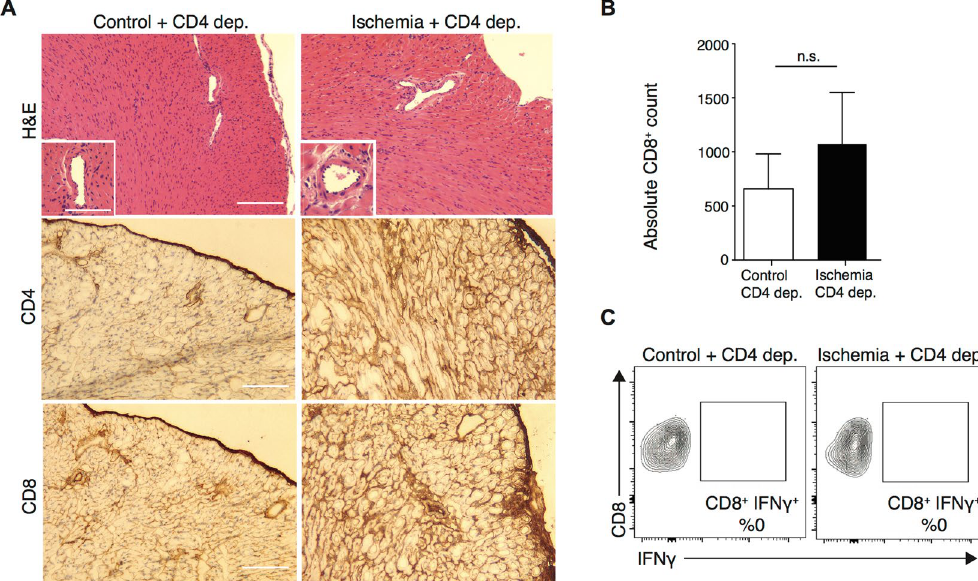
Figure 3. Depletion of CD4 + alloreactive T cells abrogates IRI-induced augmentation of intra-graft IFN γ - producing CD8 + T cells. OTII recipients were treated with anti-CD4 antibody prior to receiving control or ischemic OVA hearts. Grafts were harvested at day 6 post-transplant for analysis. ( A ) No differences in allograft infiltration or evidence of rejection seen in either group following CD4 depletion. No intra-graft CD4 + T cells were detected and rare CD8 + T cells were detected by histological analysis, with no notable difference between control and ischemic organs. (Scale bar 100 μ m for H&E, CD4 and CD8 stain. Inset scale bar 30 μ m). ( B ) There was no statistical difference between absolute number of CD8 + T cells infiltrating control and ischemic grafts as enumerated by flow cytometry (657 ± 322 vs. 1069 ± 478, p = 0.5, n = 3/group). ( C ) No IFN γ -producing CD8 + T cells were detected in the grafts after CD4 + depletion (n =